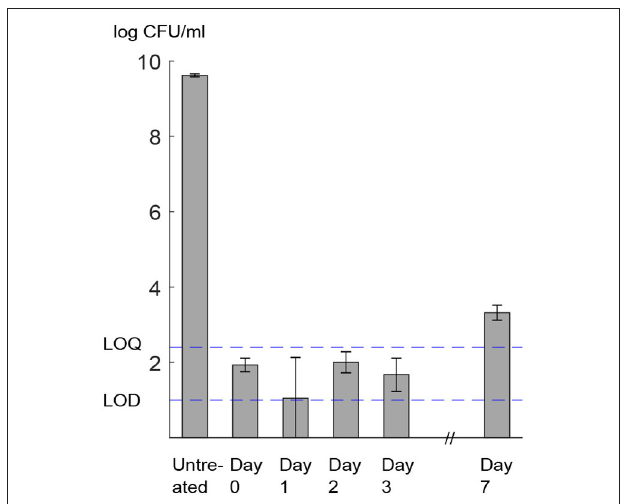
FIGURE 8 | L. monocytogenes viable cell counts (log CFU / mL ). Assessment was done by plating on non-selective medium before (untreated) and after HPP (day 0) and during storage at 8 ◦ C (day 1–7). LOD, limit of detection; LOQ, limit of quantification. Error bars show standard deviation of three biologically independent replicates. Raw data is available in Supplementary File 2 .